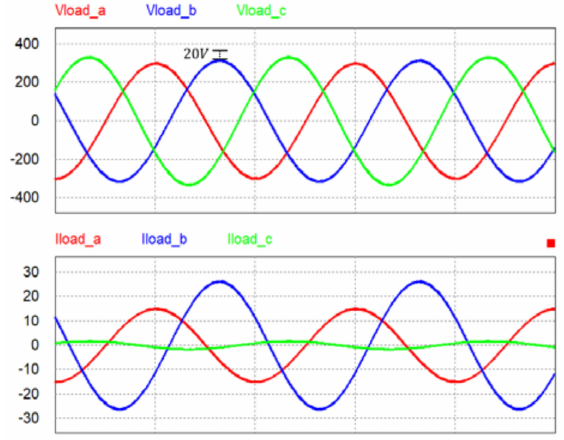
Figure 8. Simulation results of the three-limb core-type